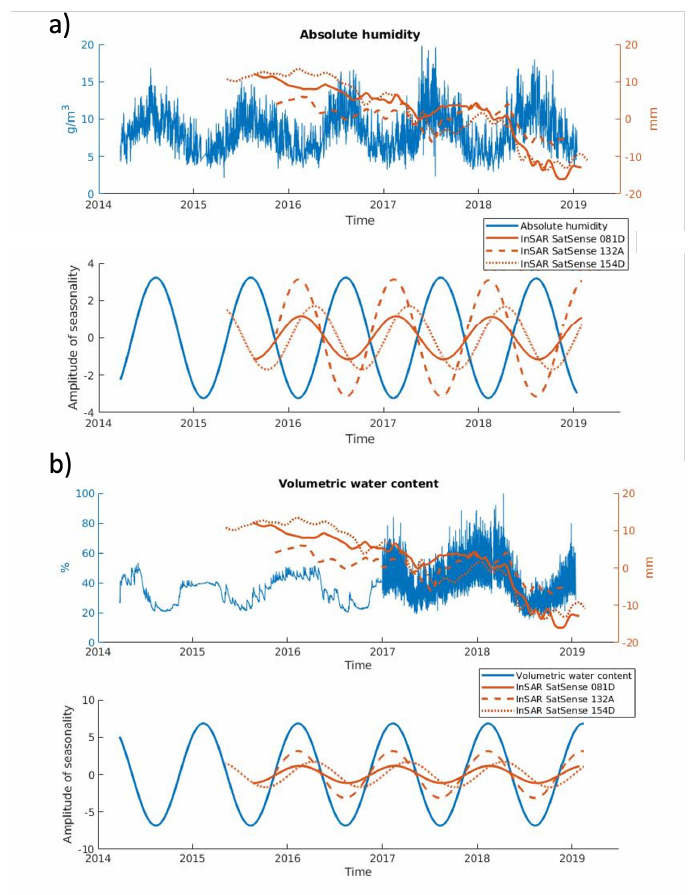
Figure 10. Comparison between the absolute humidity ( a ) and volumetric water content ( b ) measure- ments (in blue) and the average of displacement from InSAR data for each frame (in orange). The top panels show the raw data and the bottom panels show the amplitude of seasonality extracted with a sinusoid